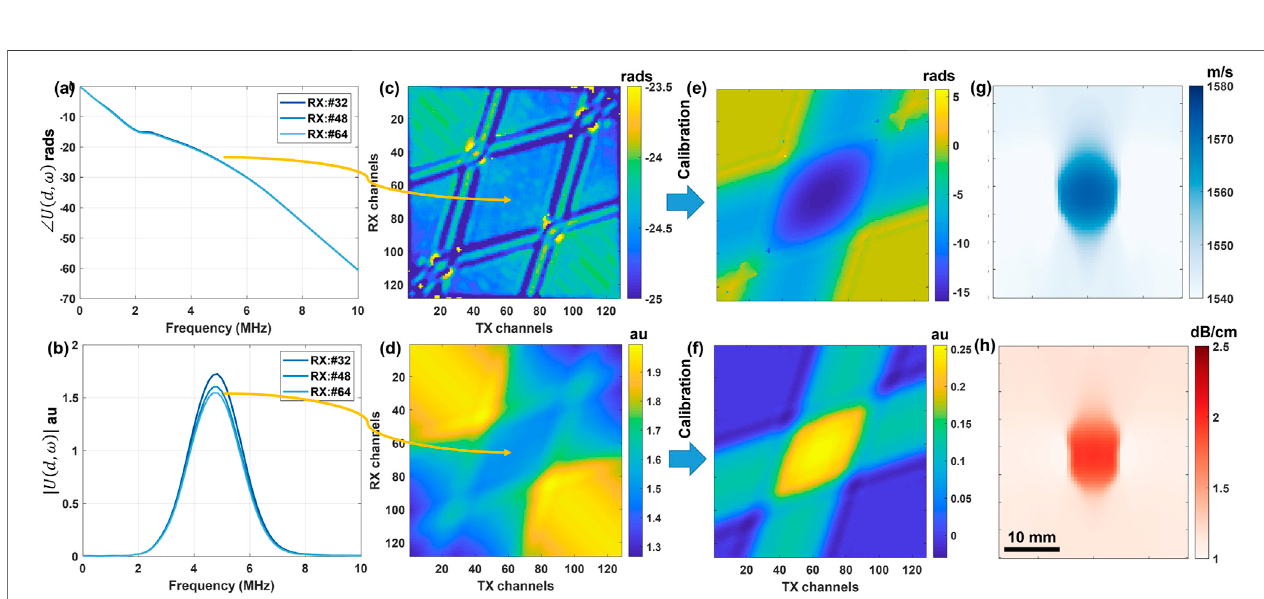
FIGURE1| (A) Schematic oftheimagingsetup where an acoustic mirror (re fl ector) ispositionedat a pre-de fi ned distancefrom theultrasound transducer surface, with coloured paths representing the traversal of different acoustic wavefront paths from a single transmit element to different receivers through a discretized tissue representation, (B) Pre-beamformed data received by all the receive channels of the transducer when the transducer element #64 is used for transmission (Tx). (C) Cropped re fl ector echo pro fi les corresponding to different Rx elements, from which the re fl ector is next delineated precisely.